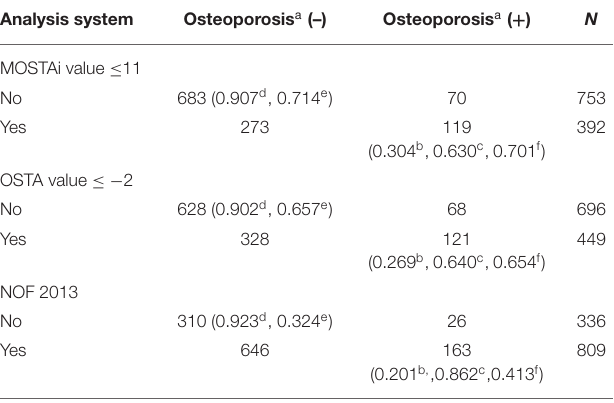
TABLE 3 | The comparison between modified male osteoporosis self-assessment tool for Taiwan (MOSTAi) index, osteoporosis self-assessment tool (OSTA) index, and National osteoporosis foundation recommendations in 2013 (NOF 2013) in the validation cohort. Analysis